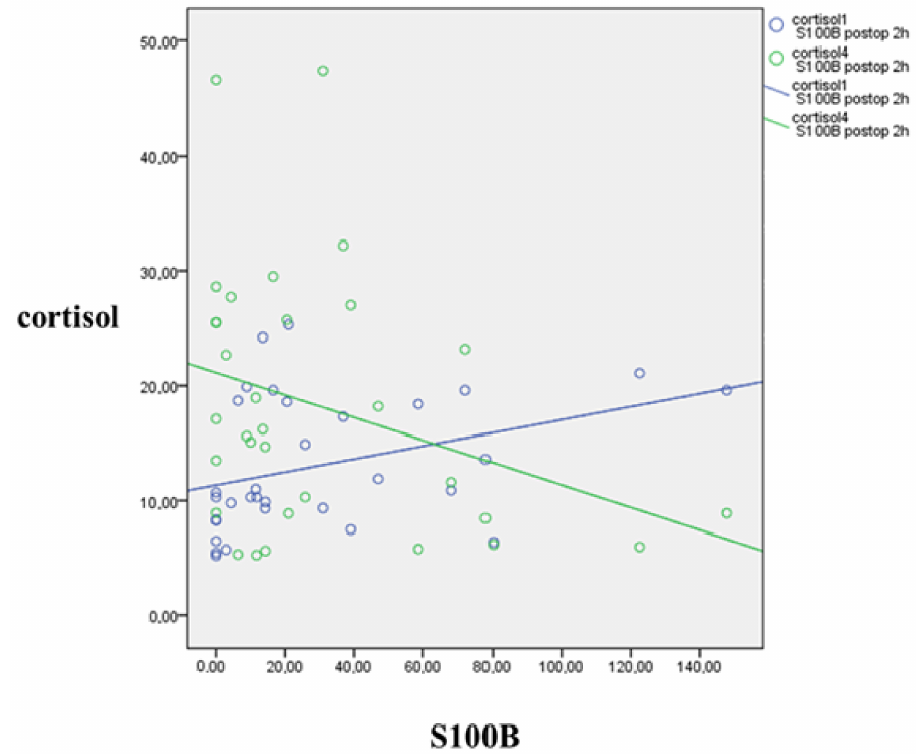
Figure 3. Correlation between concentrations of postoperative S100B (nmol/L) and cortisol (nmol/L) before and after the operation. The circles represent the plotted values for each of the variables. Blue line represents the correlation of preoperative cortisol and S100B 2 h after the operation. Green line represents the correlation of cortisol 2 h after the operation and S100B 2 h after the